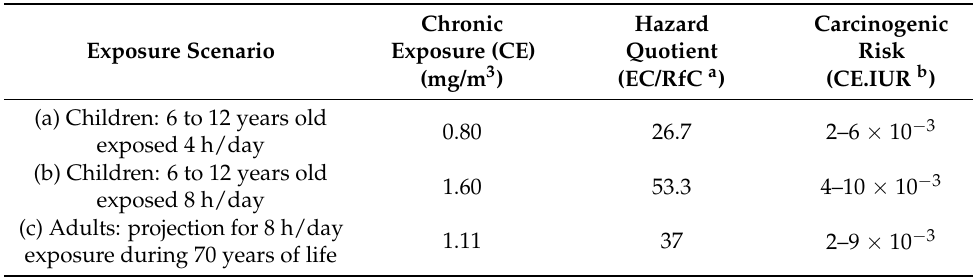
Table 1. Carcinogenic and non-carcinogenic risk from exposure to inhaled benzene in children from